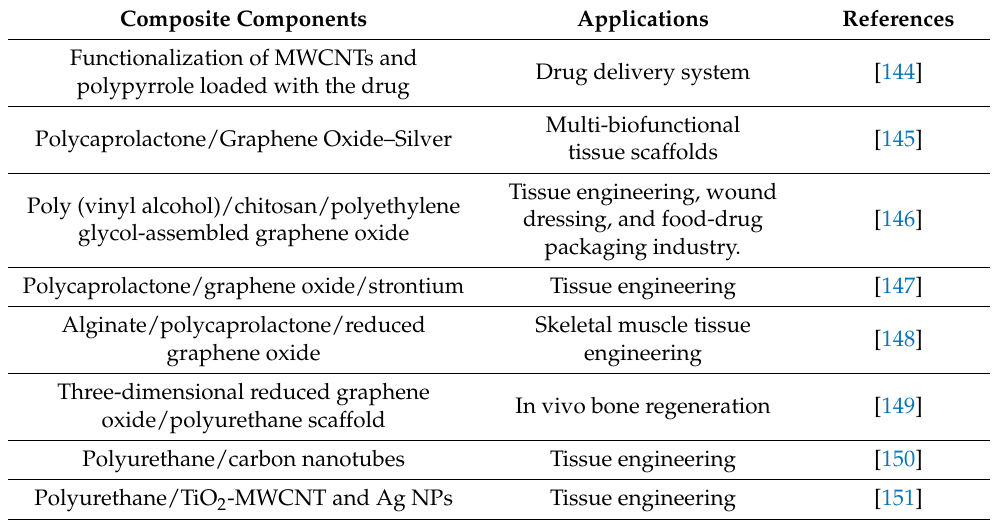
Table 1. Anoverviewontherecentreportednovelnanocompositesforanumberofbiomedicalapplications. Composite